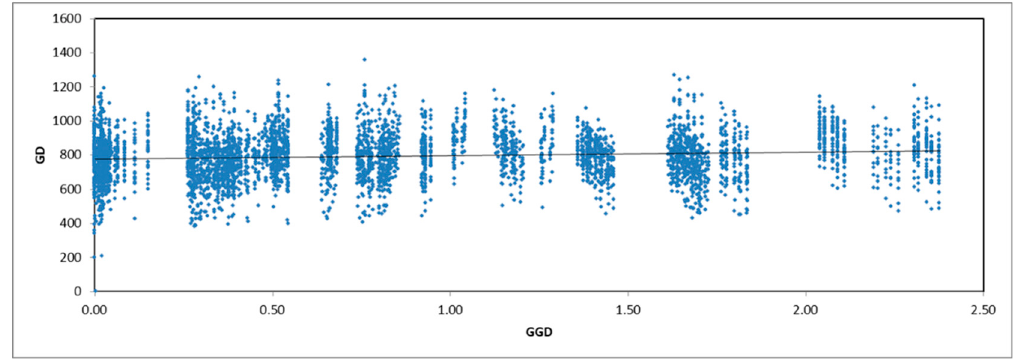
Figure 5. Mantel’s test graph of the genetic (GD) and geographic distances (GGD) among 98 landraces of Rhanterium eppaposum .